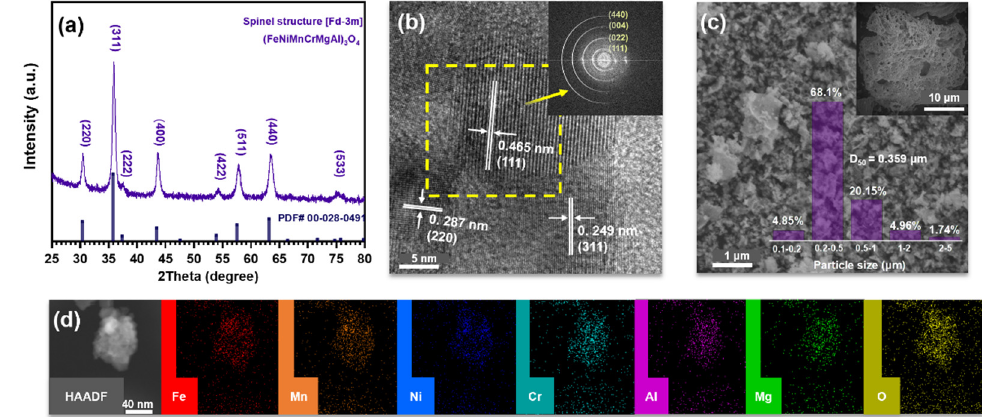
Figure 2. Structure characterization of the 6 - SHEO. ( a ) XRD pattern, ( b ) HRTEM image and corre- sponded FFT pattern of the selected area, ( c ) SEM images and particle size distribution, ( d ) STEM-